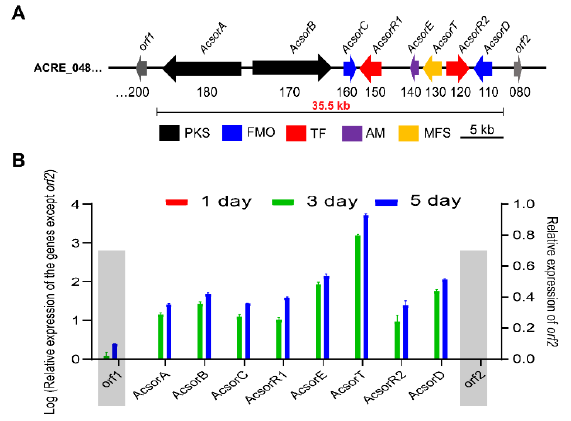
Figure 6. ( A ) Organization of the sorbicillinoid biosynthetic gene cluster. FMO, FAD-dependent monooxygenase; PKS, polyketide synthase; TF, transcriptional factor; AM, auxiliary modifier; MFS, major facilitator superfamily transporter. ( B ) Transcriptional profiles of the Acsor genes during fermentation.